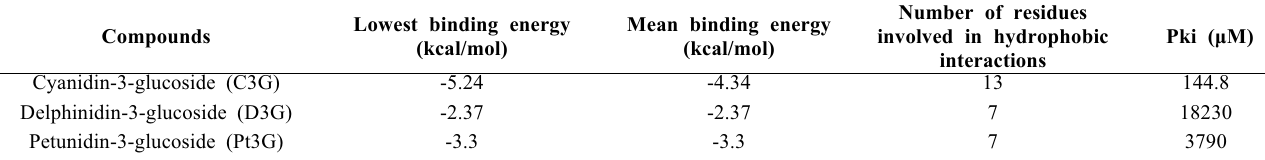
Tab. S4: In silico blind molecular docking of anthocyanins to tyrosinase.